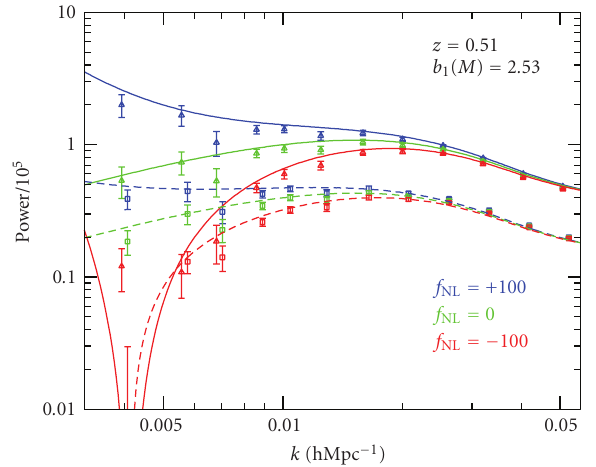
Figure 8: Halo-halo (solid curve) and halo-matter (dashed curve) power spectra P h ( k ) and P h δ ( k ) measured in simulations of the = ± 100 models for halos of mass M > 2 × Gaussian and f loc NL 10 13 M (cid:14) /h at redshift z = 1. The error bars represent the scatter = − 100, the crosspower spectrum is among 8 realizations. For f loc NL negative on scales k (cid:2) 0 . 005hMpc − 1 , in good agreement with the theoretical prediction.